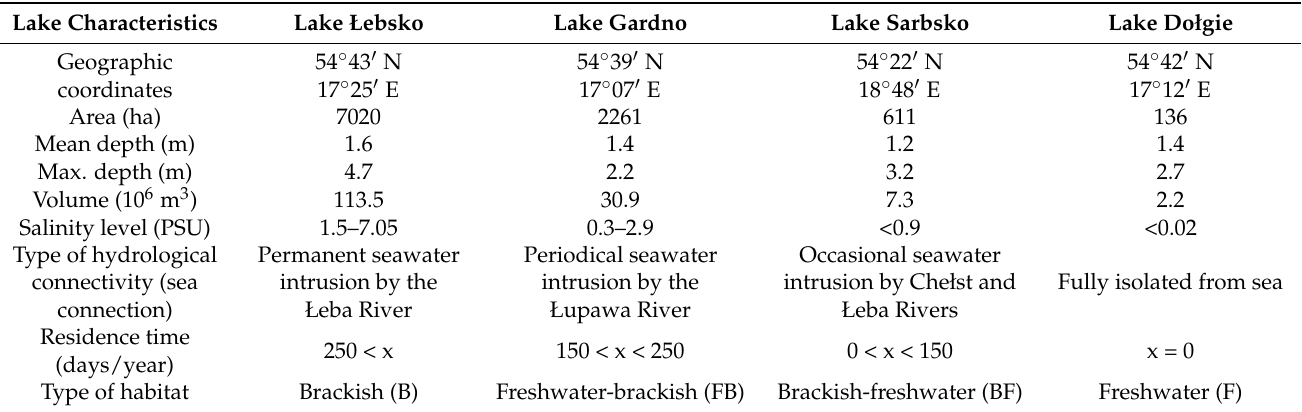
Table 1. Morphological characteristics of the coastal lakes studied in a salinity gradient [7,22,23].